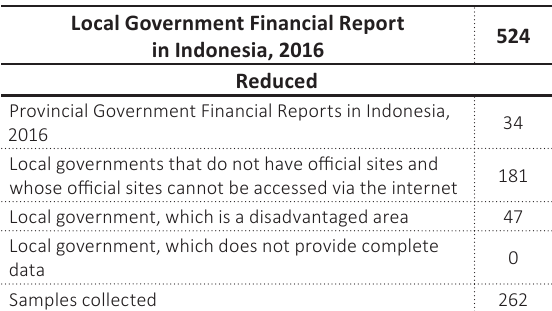
Table 1. Sample selection summary